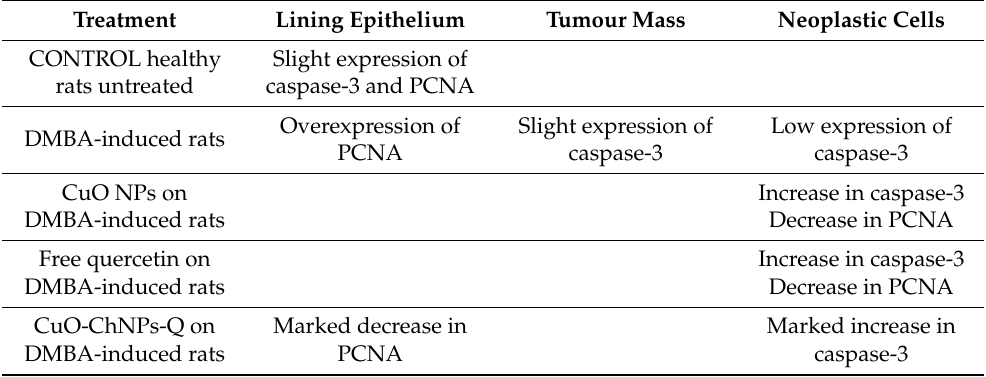
Table 4. Changes in caspase-3 antibody and PCNA antibody in mammary gland tissue. PCNA is proliferating cell nuclear antigen (adapted from Elsayed et al. [105]) with permission. Treatment Lining Epithelium Tumour Mass Neoplastic Cells CONTROL healthy Slight expression of rats untreated caspase-3 and PCNA Overexpression of Slight expression of Low expression of DMBA-induced rats PCNA caspase-3 caspase-3 CuO NPs on Increase in caspase-3 DMBA-induced rats Decrease in PCNA Free quercetin on Increase in caspase-3 DMBA-induced rats Decrease in PCNA CuO-ChNPs-Q on Marked decrease in Marked increase in DMBA-induced rats PCNA